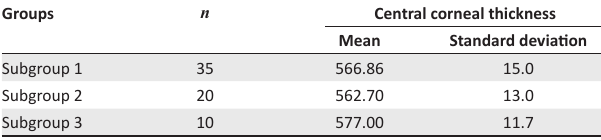
TABLE 3: Central corneal thickness in microns of the subgroups of diabetic